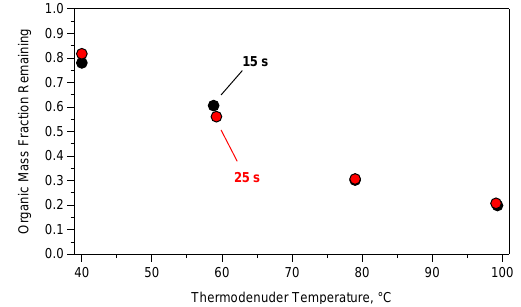
Figure 7. Organic mass fraction remaining as a function of ther- modenuder temperature at a residence time of 15s (black) and 25s (red) for Expt. 7. Thermograms have been corrected for TD losses.